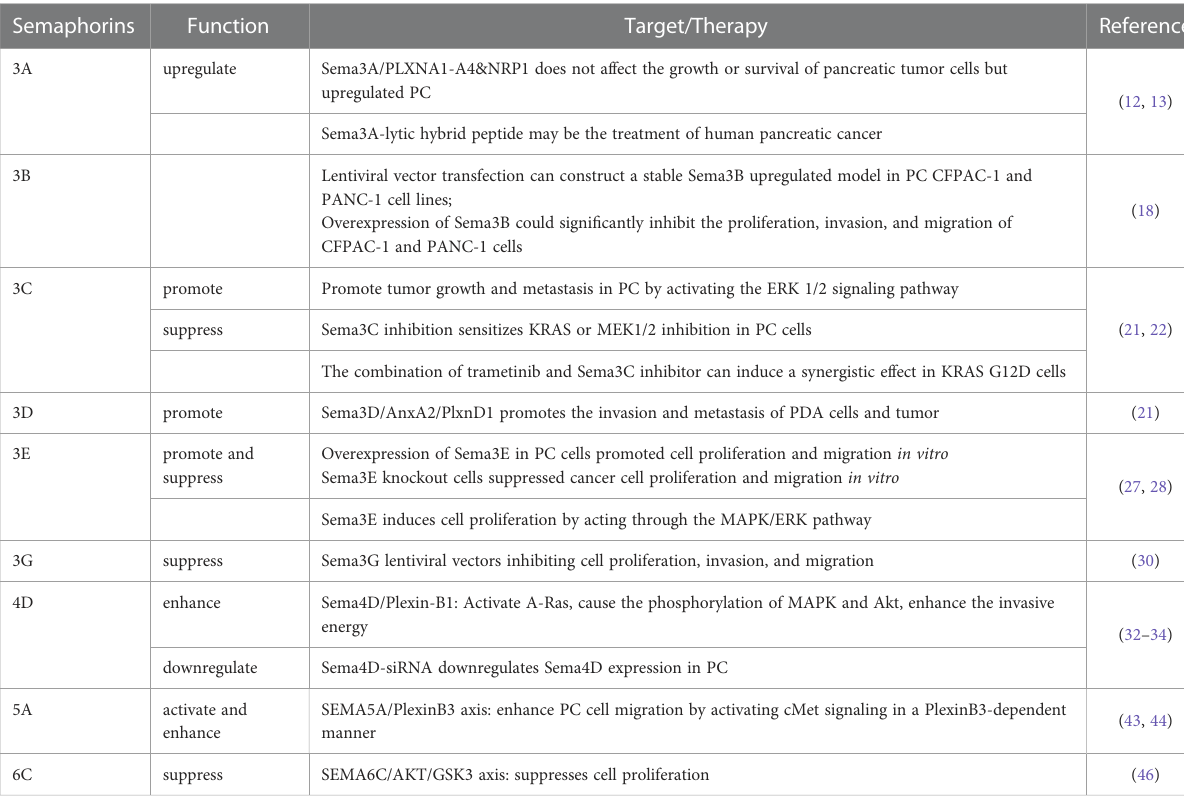
TABLE 1 Related targets and treatment of semaphorins in pancreatic cancer.